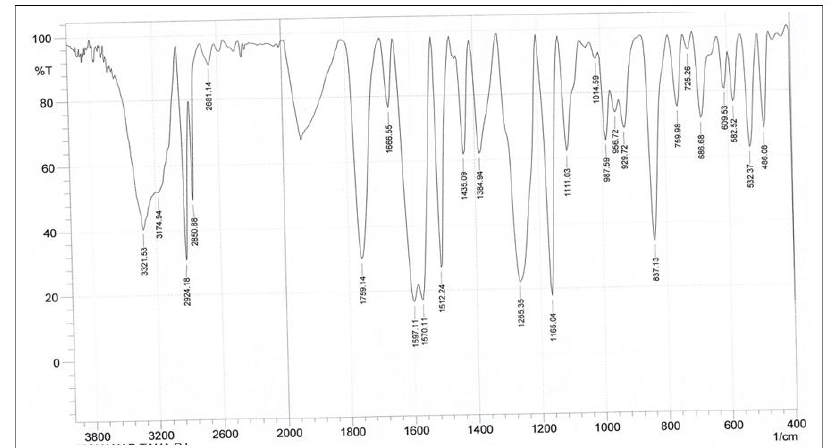
Fig. 2. FT-IR spectrum of PB polyester